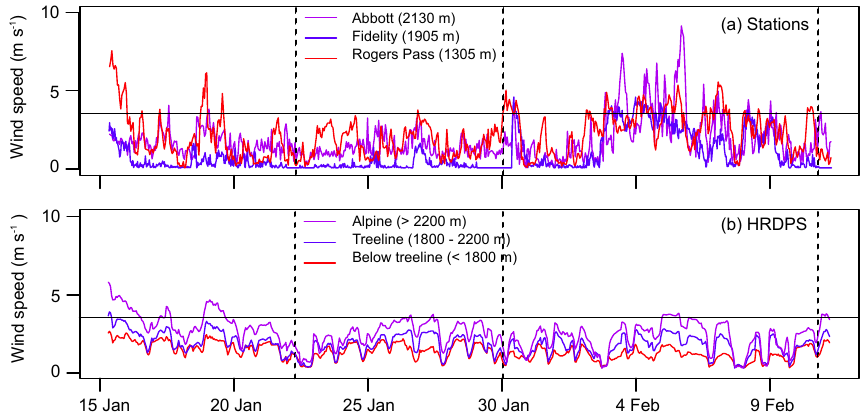
Figure 5. Wind speeds (a) measured at stations and (b) forecast by the High-Resolution Deterministic Prediction System (HRDPS) in Glacier National Park. The 3.5ms − 1 threshold is shown with a horizontal line. Same format as Fig.